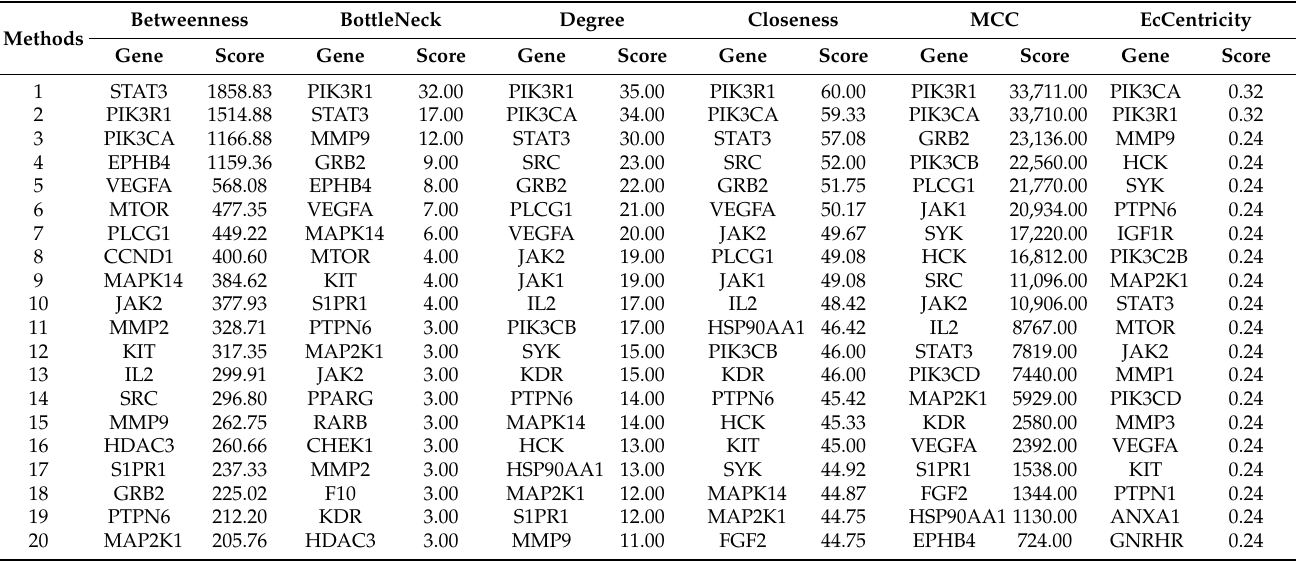
Table 2. Top 20 key genes of the GCK–osteoporosis PPI network identified through the Betweenness, BottleNeck, Degree, Closeness, MCC and EcCentricity method based on cytoHubba